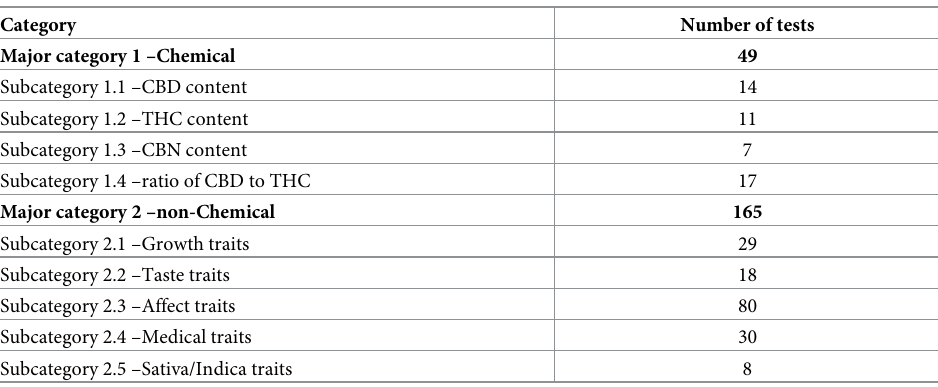
Table 1. Phenotype